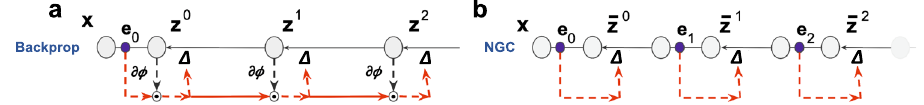
Fig. 1 Backprop in contrast with neural coding. a Credit assignment in backprop requires a strict, global feedback pathway, which requires the completion of the forward pass that carries information upstream (right to left). This feedback pathway carries the error message e 0 at the output layer back along (left to right) the same synapses used in the forward pass to update downstream neurons (cid:1) z 1 and (cid:1) z 2 . b Our proposed neural generative coding (NGC) model sidesteps this neurobiologically implausible requirement by learning with short, local error transmission pathways made possible through recurrent error synapses and stateful neural activities. Credit assignment under NGC operates with local mismatch signals, e 1 and e 2 , that readily communicate this information to their respective layers, (cid:1) z 1 and (cid:1) z 2 . Black arrows indicate forward propagation while red arrows indicate backwards transmission. Solid lines indicate that a signal is transformed along a synapse(s) while dashed arrows indicate direct copying of information (in other words, it represents the identity function, or that no transformation is applied to the incoming information). ∂ ϕ shows communication of the neuron ’ s fi rst derivative, Δ represents the computed change to the synapse (of the forward pass) that will use the (nearby) error signal, and ⊙ indicates multiplication of the